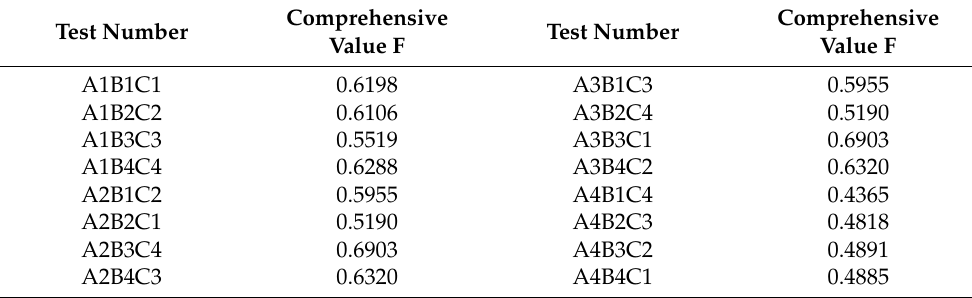
Table 7. Data processing results of the test for the performance of irrigation